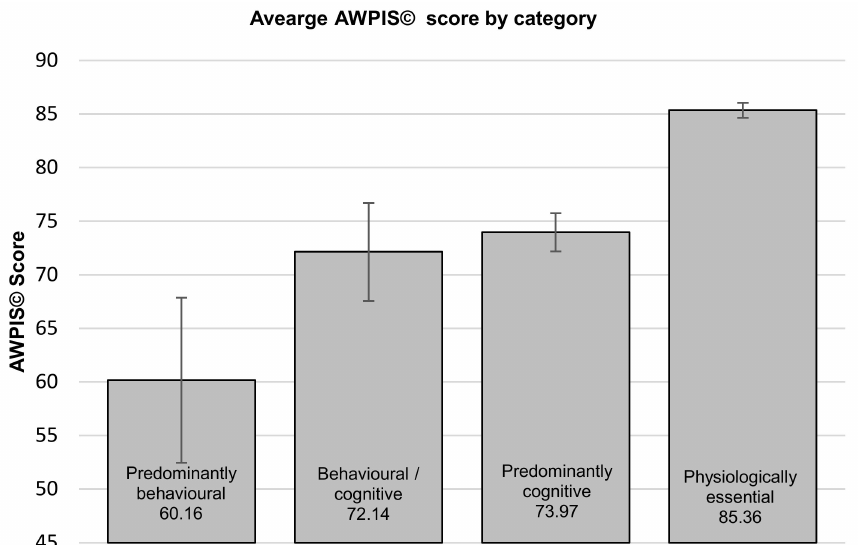
Figure 2. Comparison of group means ± standard error across the four categories of behavioural and cognitive priorities (ANOVA (F(3,22) = 2.747, p = 0.067).